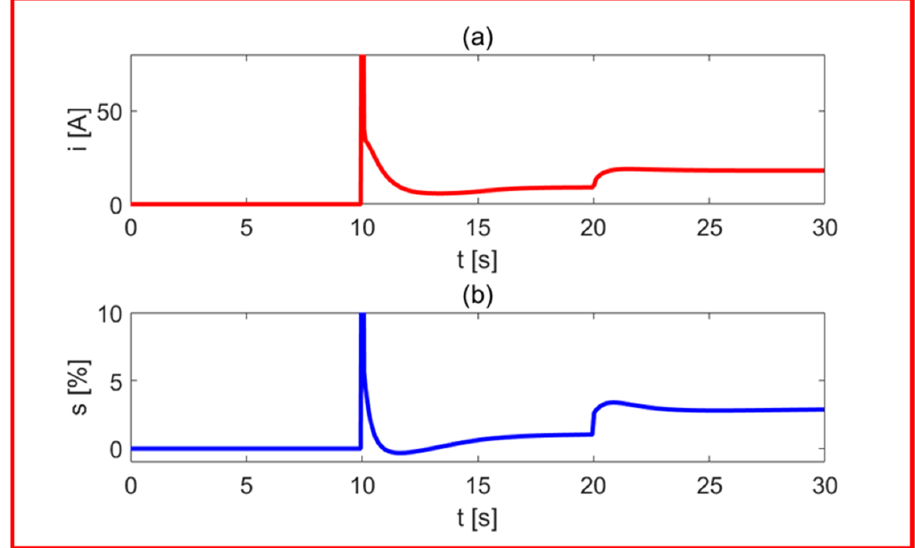
Figure 17. Current consumed from the power network ( a ) and the resulting rotor slip ( b ).